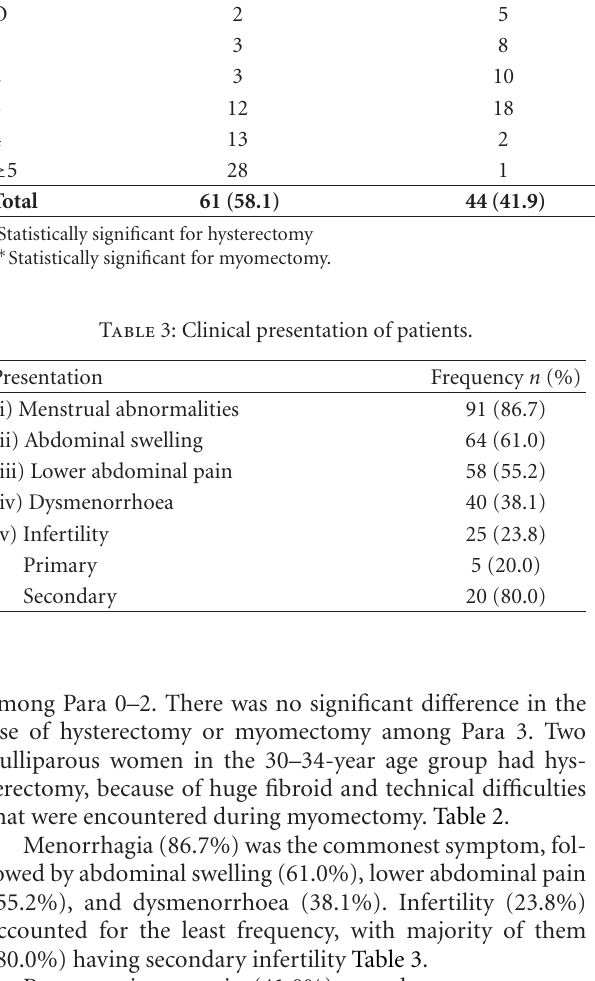
Table 2: Parity and type of operation performed on the patient.